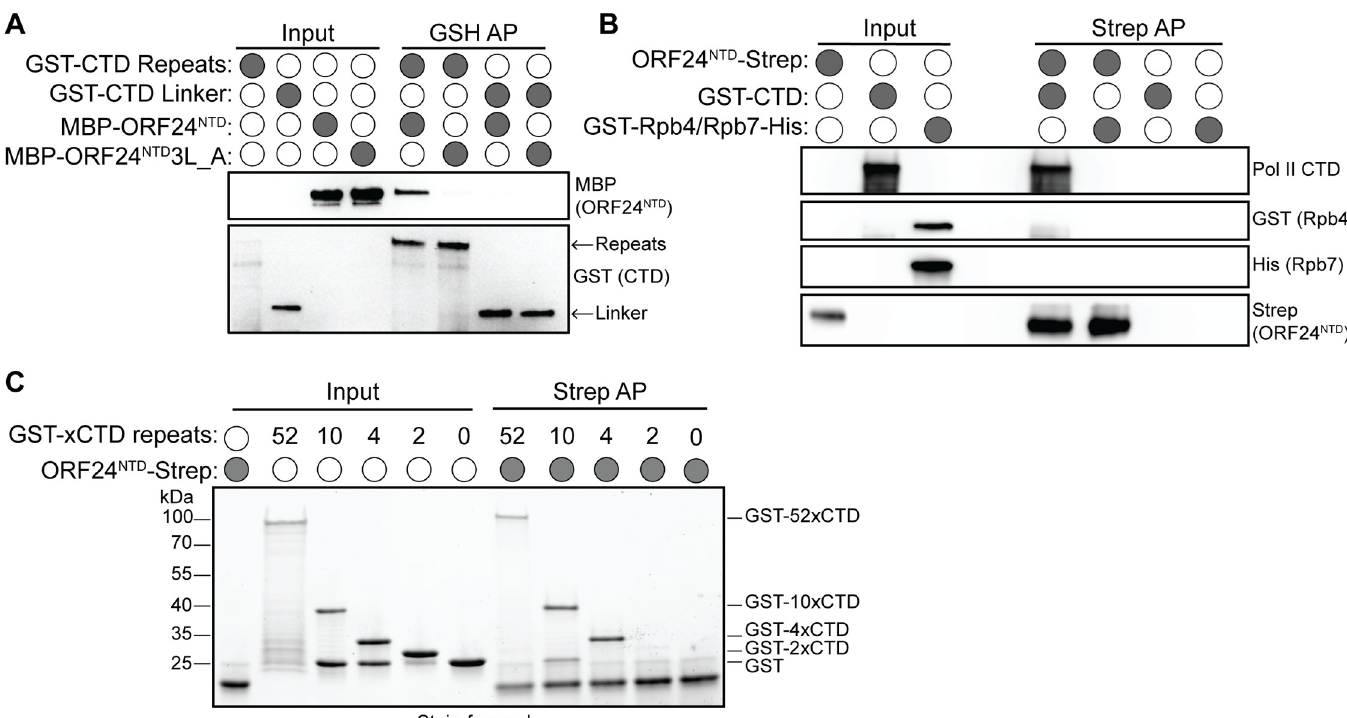
Fig 5. ORF24-NTD directly interacts with four heptapeptide repeats of the Pol II CTD. (A) Recombinantly purified GST-CTD repeats or the GST-CTD linker were incubated with either purified MBP-ORF24-NTD or MBP-ORF24-NTD-3L_A protein, then subjected to a glutathione pulldown (GSH AP). Samples were resolved by SDS-PAGE and analyzed by western blot. (B) Recombinantly purified GST-CTD repeats or GST-Rpb4/His-Rpb7 heterodimer were incubated with recombinantly purified Strep-tagged ORF24-NTD, then subjected to a StrepTactinXT pulldown (AP). Samples were resolved by SDS-PAGE and analyzed by western blot.